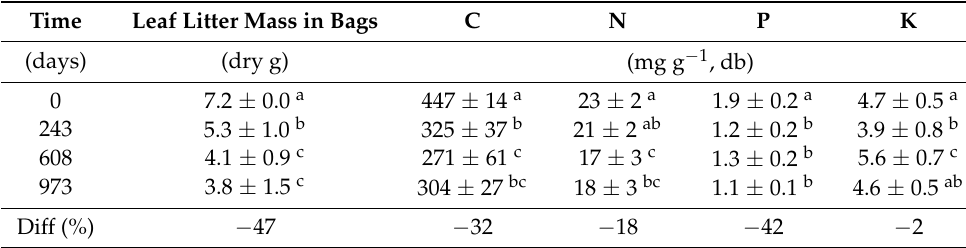
Table 4. Nutrient concentration in decomposing leaf litter over time.